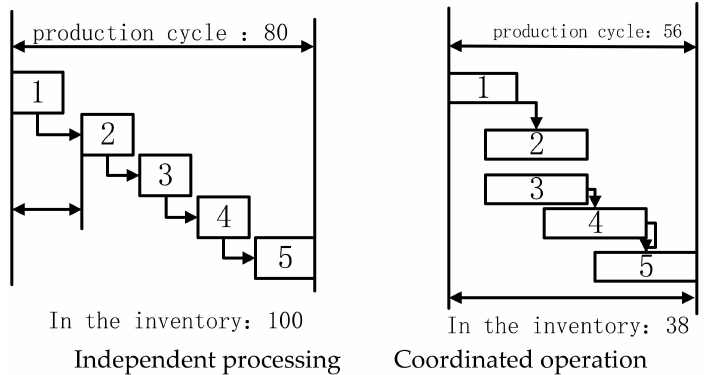
Figure 5. Multi-product processing time